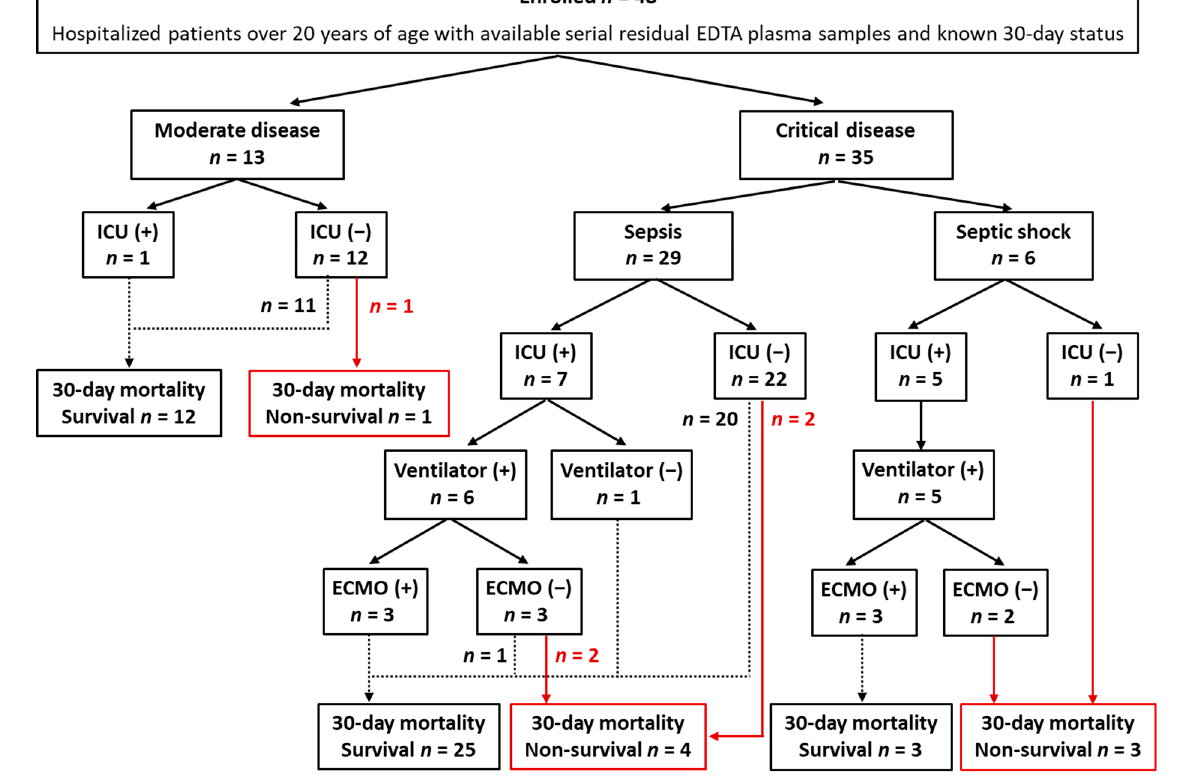
Figure 1. The diagram of enrollment and clinical outcomes of the study population. None of the study population presented mild or severe disease of WHO disease severity. Dotted and red lines indicate survival and death with regard to 30-day mortality, respectively. Abbreviations: EDTA, ethylene-diamine-tetraacetic acid; ICU, intensive care unit; ECMO, extracorporeal membrane oxy- genation.